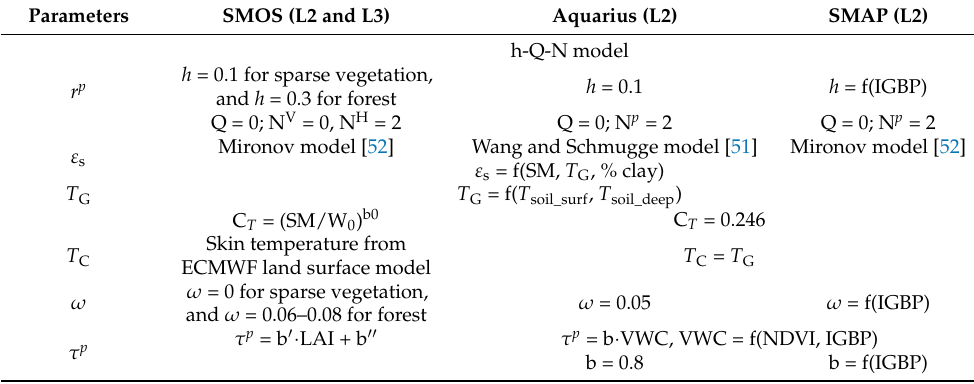
Table 2. Parameterizations adopted by the SMOS, Aquarius, and SMAP satellite missions for key parameters in the forward land emission